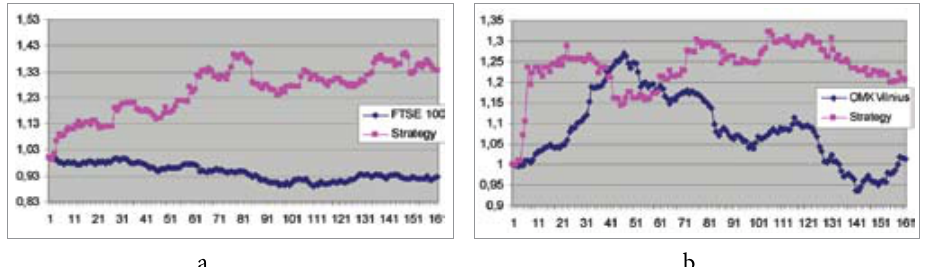
Fig. 4. Comparison of indices and strategy using results on capital markets: